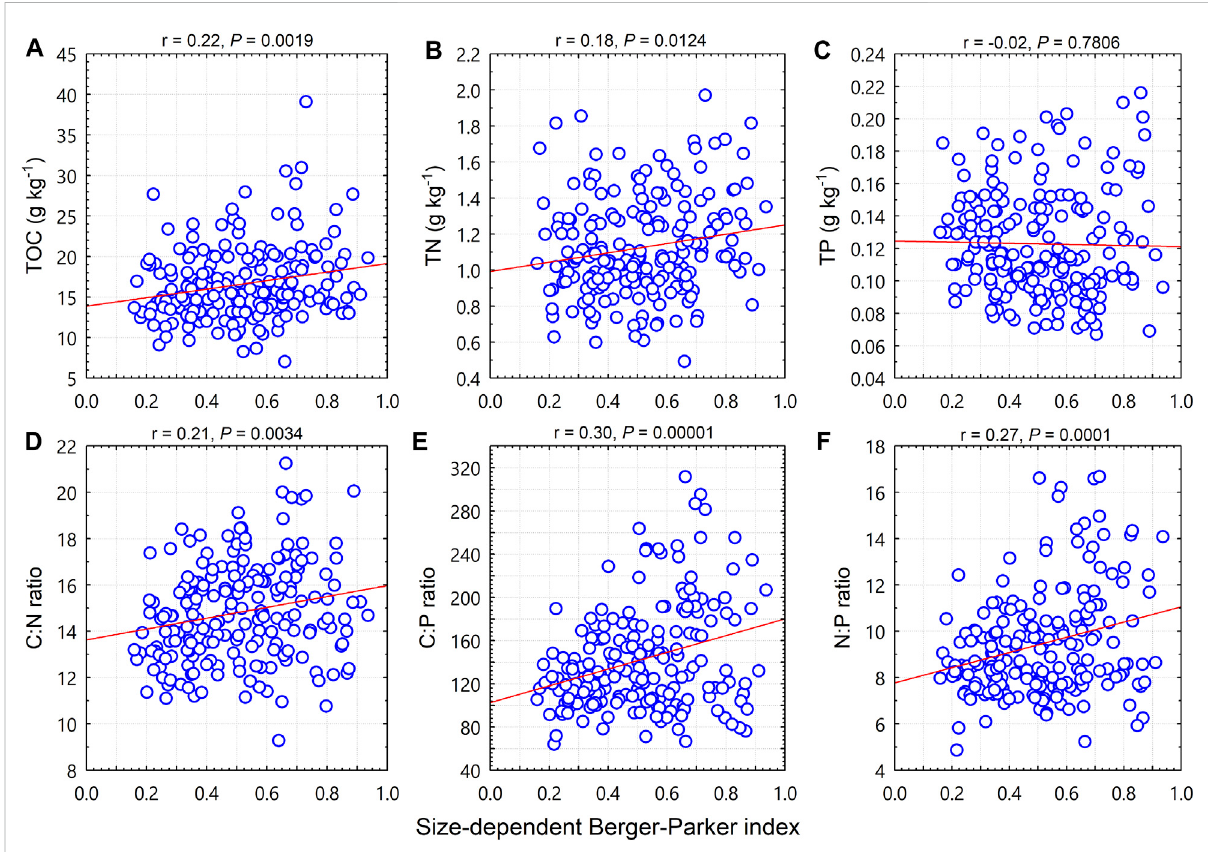
FIGURE 5 Relationships between woody plant size-dependent Berger-Parker and soil total organic carbon (TOC), total nitrogen (TN), total phosphorus (TP), and C:N:P stoichiometric